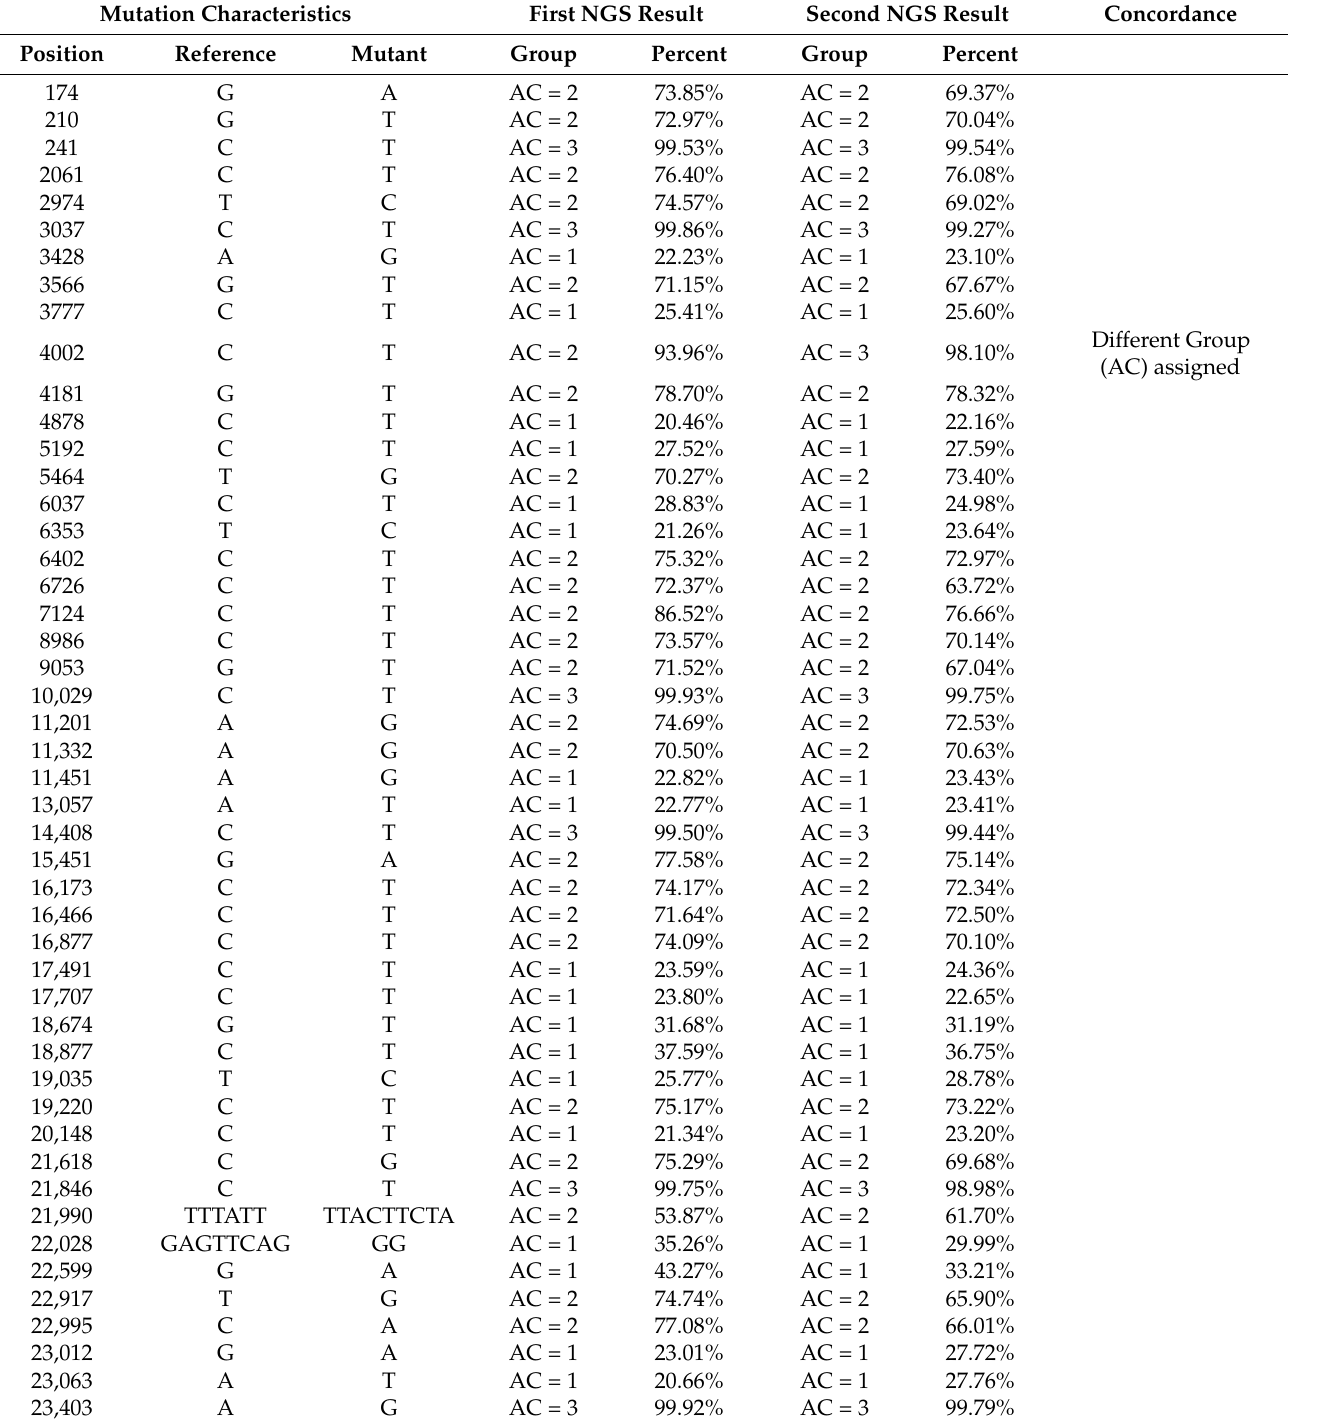
Table 7. Comparison between NGS results of sample